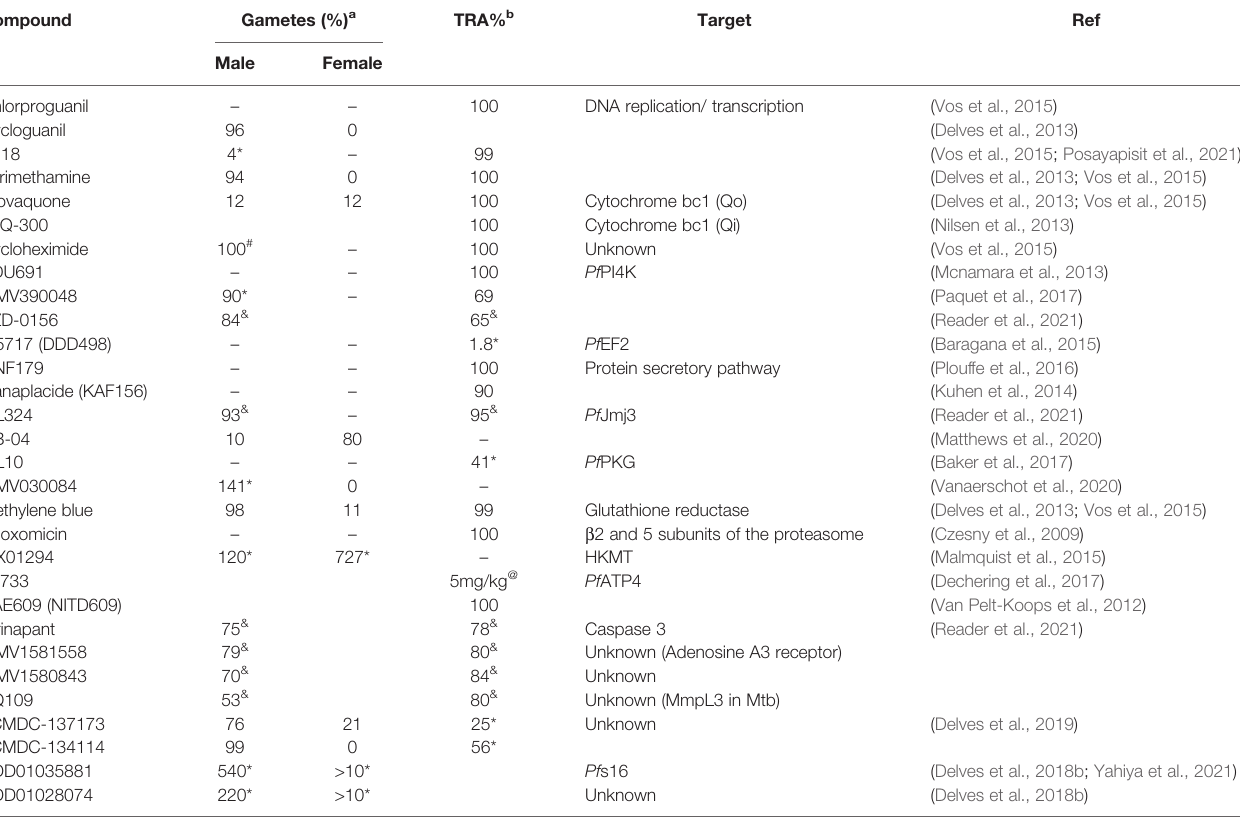
TABLE 3 | Summary of key antimalarials, front-runner and development compounds as well as investigative hits with in vitro activity (>70% inhibition, or < 5 µM IC 50 ) against male and female gametes, as well as oocyst formation.